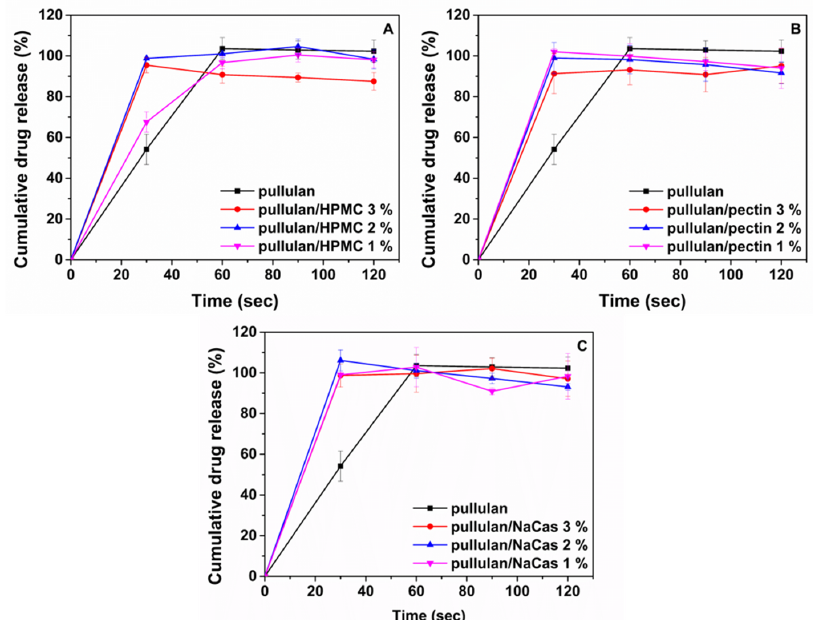
Figure 7. In vitro drug release profiles of ISO from the ODFs in simulated salivary fluid pH 7.0 at 37 °C.